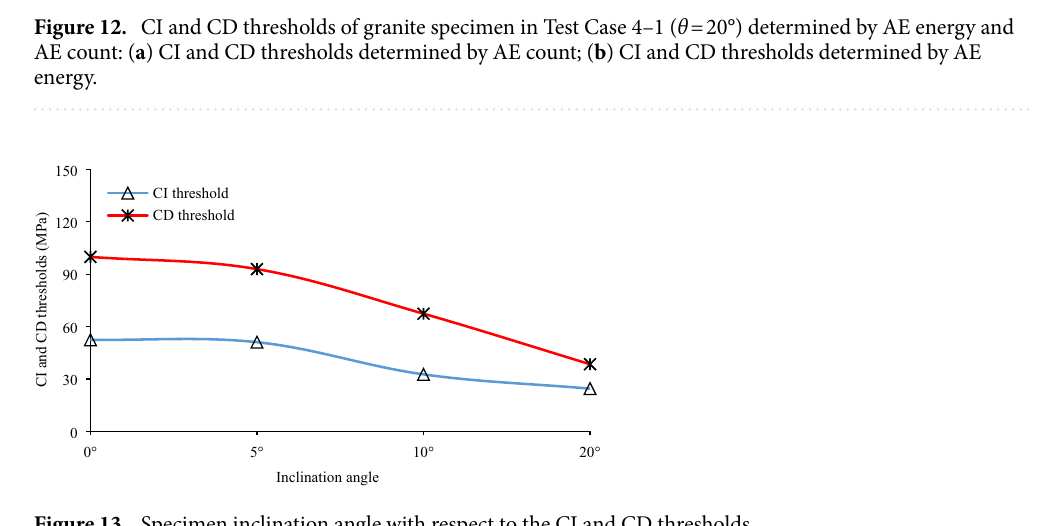
Figure 13. Specimen inclination angle with respect to the CI and CD